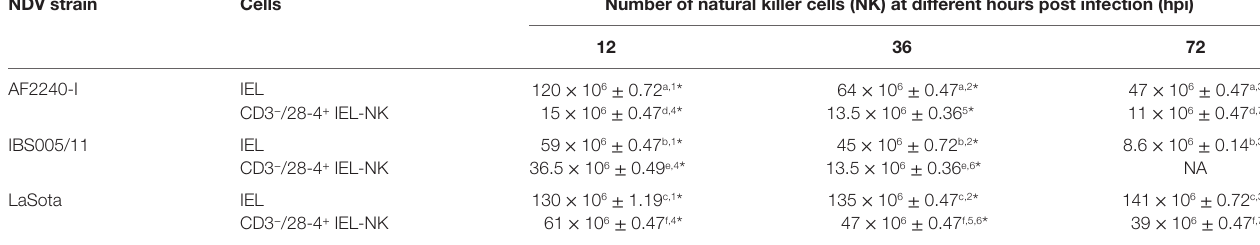
TaBle 1 | Cell count. nDV